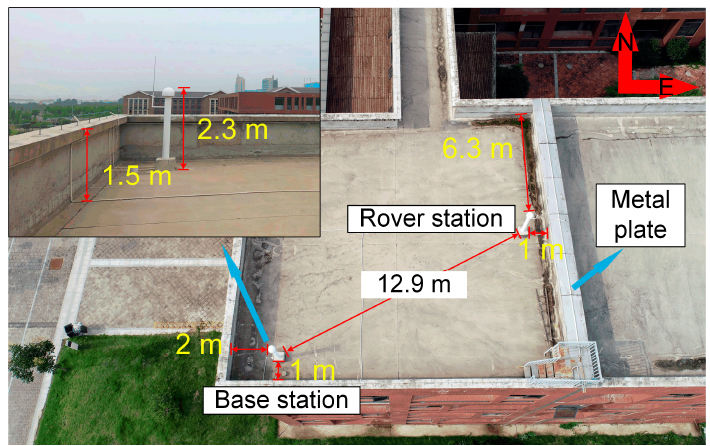
Figure 4. Observation environment around the stations.